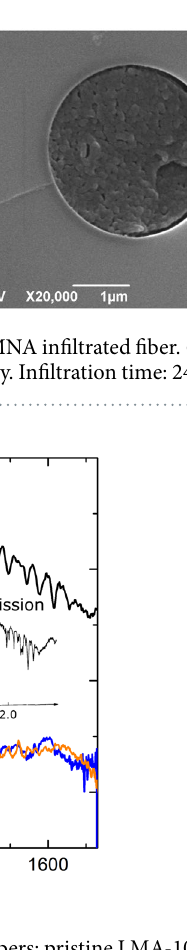
Figure 2. Transmission spectra of 20 mm long optical fibers: pristine LMA-10 (black line) and MNA-filled LMA-10 (blue line). Scattered light spectrum from the side of the MNA-LMA fiber (orange line). Graph inset: MNA transmittance, modified from 2